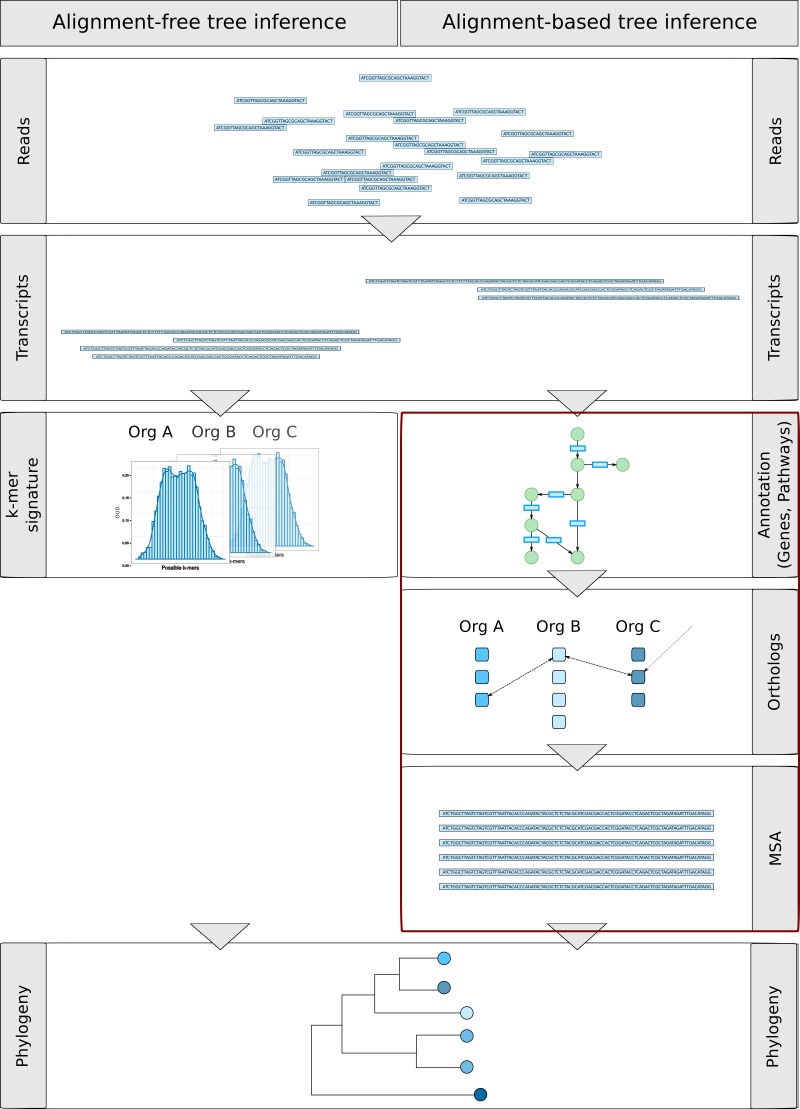
Overview of alignment-free and alignment-based gene-centric approaches of phylogenetic inference.Both approaches include the assembly of reads to transcripts using Trinity (Grabherr et al., 2011). Based on the transcript sequences in the alignment-free approach, k-mers were counted (4-mers and 6-mers) and used to calculate transcriptome signatures. Using the euclidean distance between the signatures, trees were constructed using the Unweighted Paired Group Method with Arithmetic Mean (UPGMA). In contrast, for the alignment-based approach, the steps marked in red differ. Here the transcripts were annotated with KEGG genes, pathways and KEGG orthology information (Kanehisa & Goto, 2000). The KEGG orthology information was used to find orthologous genes between all strains. Multiple sequence alignments were constructed with MAFFT (Katoh & Standley, 2013) using overlapping regions of the transcripts of all 18 strains. One or several transcripts, constituting splice variants or alternative assemblies, were included if they feature an adequate length. Based on the multiple sequence alignments, a model test was performed and a bootstrapped maximum-likelihood phylogeny estimated.